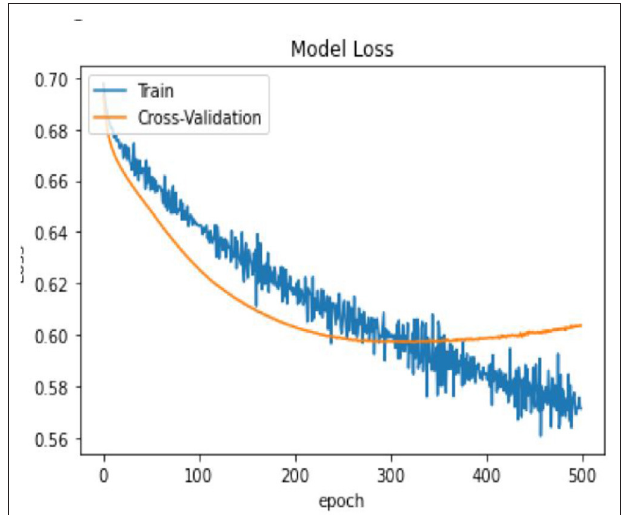
FIGURE 7 | ANN model loss pooled set.